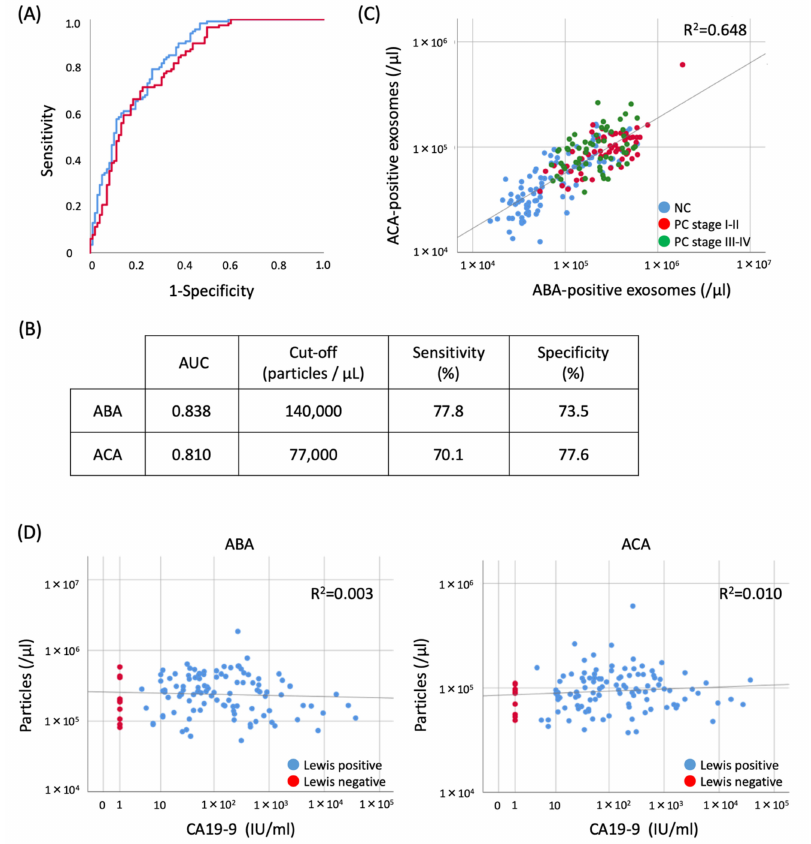
Figure 6. Characteristics of ABA- or ACA-positive EVs in PC sera. ( A ) The ROC curve obtained for ABA-positive EVs (blue line) and ACA-positive EVs (red line) di ff erentiates PC patients from NC. ( B ) The AUC, a cut-o ff value, sensitivity, and specificity are described, respectively. ( C ) Scatter plots of ABA- and ACA-positive EVs in sera. Blue, red, and green dots indicate NC, PC stage I-II (early stage), and III-IV (advanced stage), respectively. ( D ) Scatter plots of the ABA- or ACA-positive EVs and CA19-9 in PC sera. Red and blue dots indicate Lewis antigen negative and positive patients,